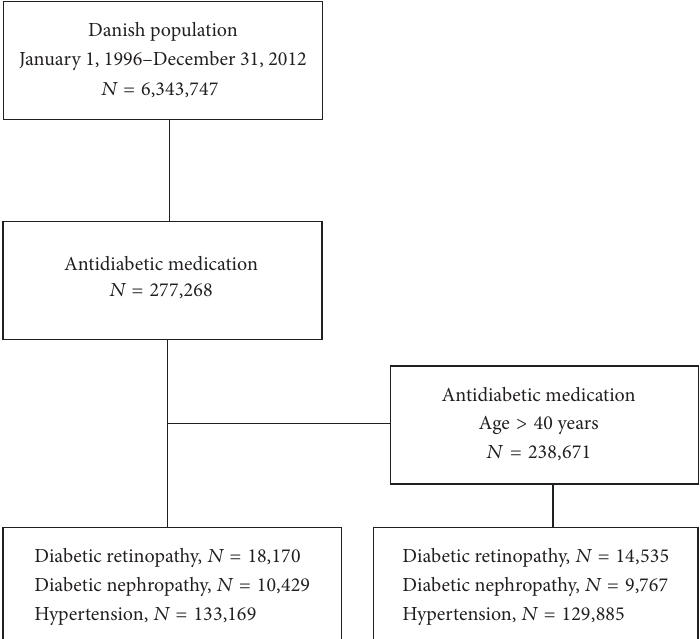
Figure1:FlowchartofdiabetesmellitusandglaucomaintheDanishpopulationintheperiodfrom1996to2012.TheNationalDanishRegistry of Medicinal Products Statistics was used to identify all individuals who were treated with glaucoma medication and/or antidiabetic